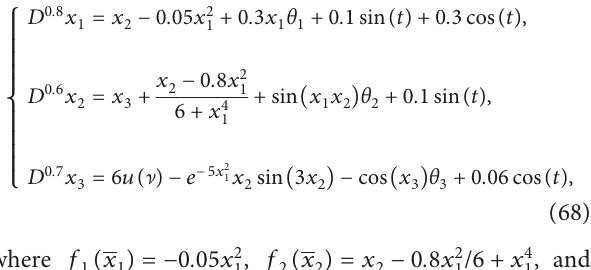
Figure 1: Evolution of y , y